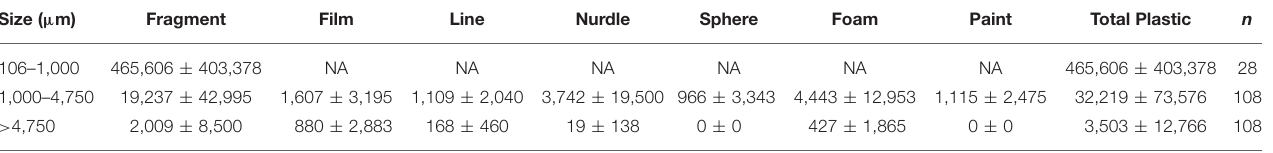
TABLE 1 | Mean and standard deviations of plastic type concentrations (km − 2 ) across all trawls and size classes quantified.